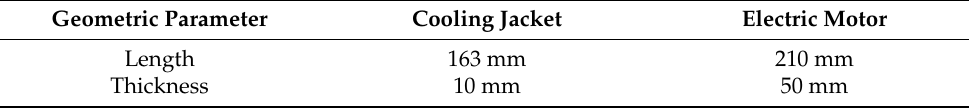
Table 1. Dimensions of E